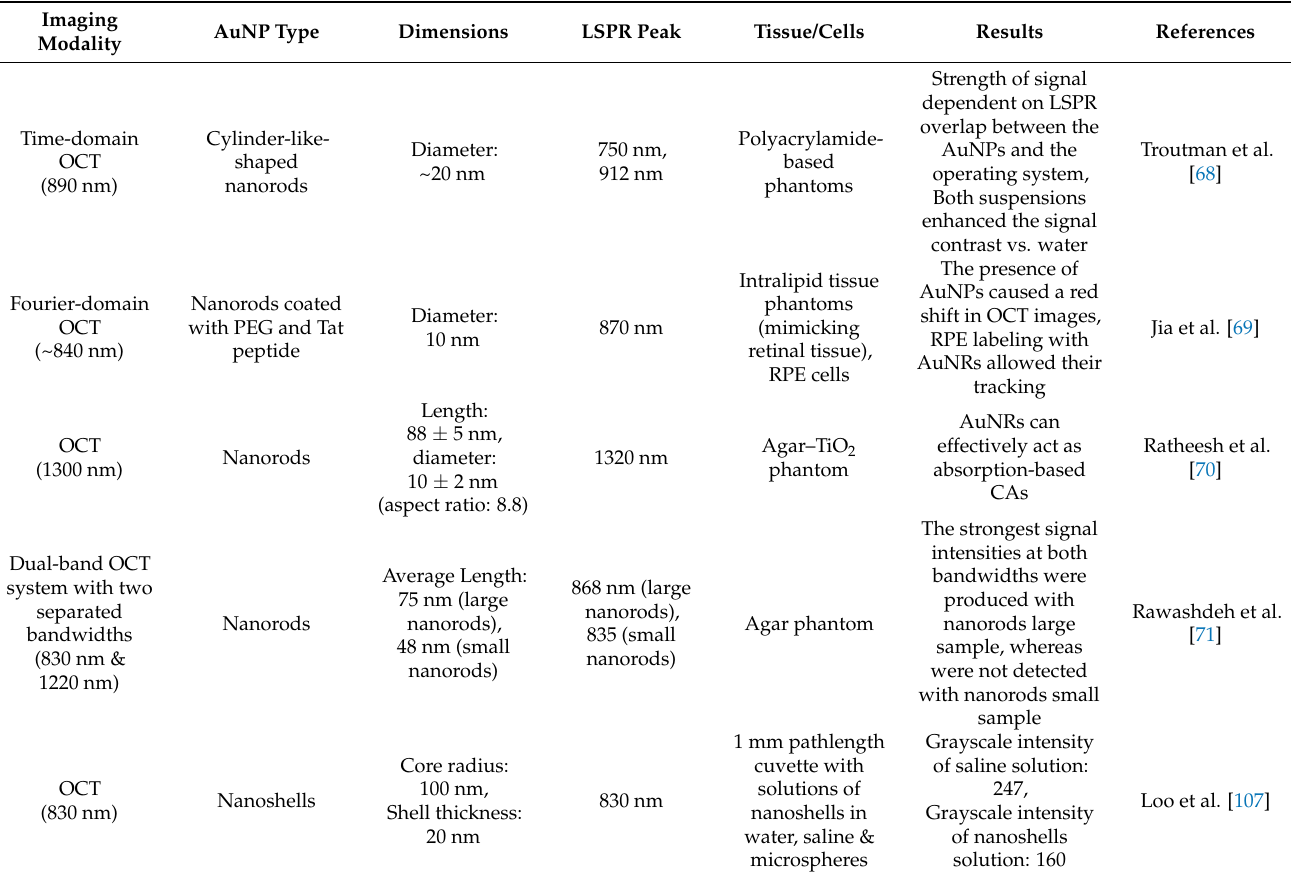
Table 1. In vitro studies examining the use of gold nanoparticles as contrast agents for OCT &